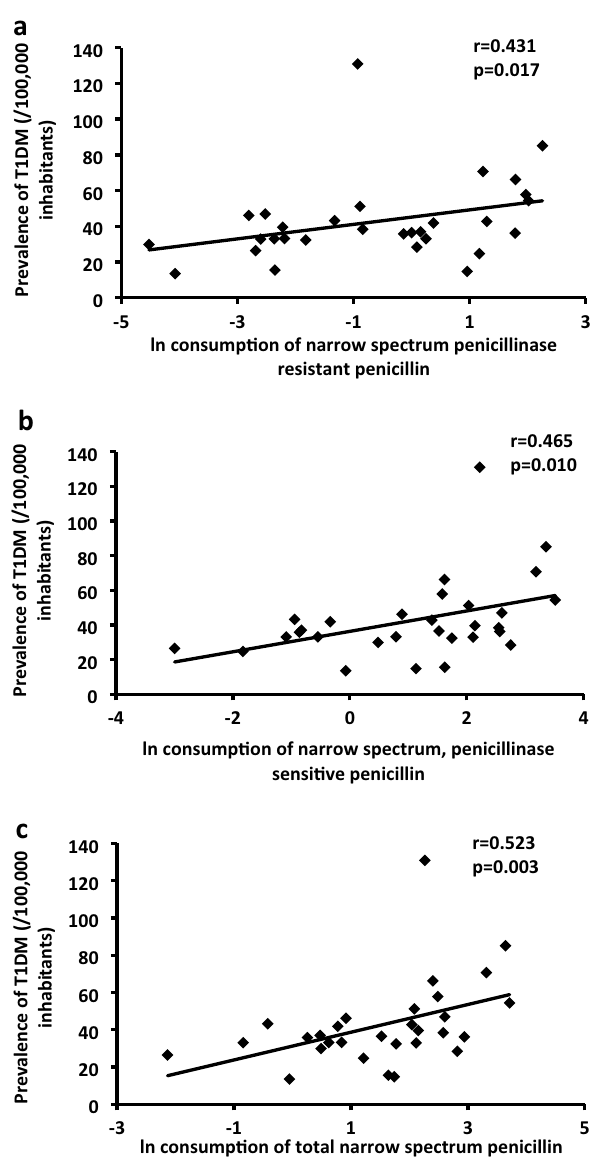
Figure 2. Association of consumption of narrow spectrum, penicillinase sensitive penicillin ( a ), narrow spectrum penicillinase resistant penicillin ( b ) and total narrow spectrum penicillin ( c ) with prevalence of T1DM (0–19 years). Total narrow spectrum penicillin represents narrow spectrum, penicillinase sensitive penicillin + narrow spectrum penicillinase resistant penicillin. Antibiotic consumptions were expressed in natural logarithm, regarding their